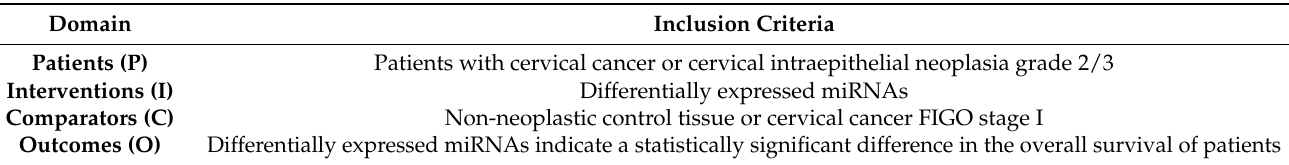
Table 1. Eligibility criteria in accordance with PICO (participants, interventions, comparisons, outcomes). Domain Inclusion